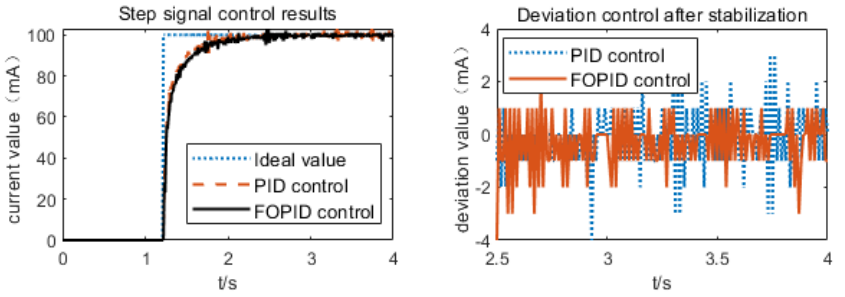
Figure 10. Control circuit test bench and test procedure.